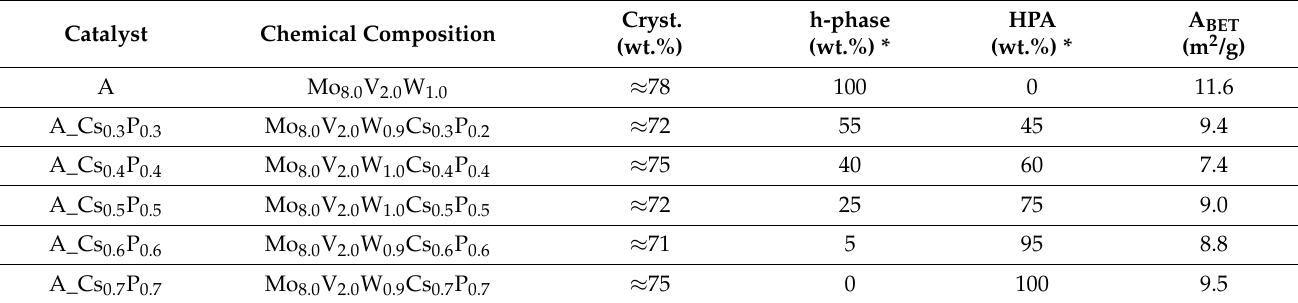
Cryst. h-phase HPA A BET (wt.%) (wt.%) * (wt.%) * (m 2 /g)